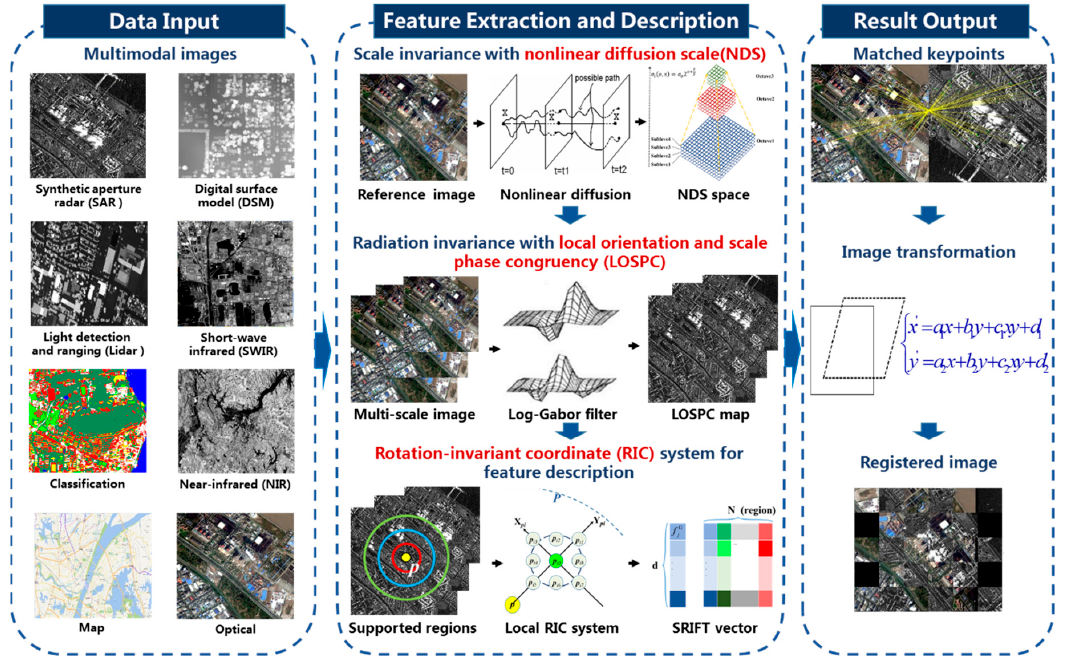
Figure 1. Multimodal image registration flowchart based on scale-radiation-rotation-invariant feature transform (SRIFT).